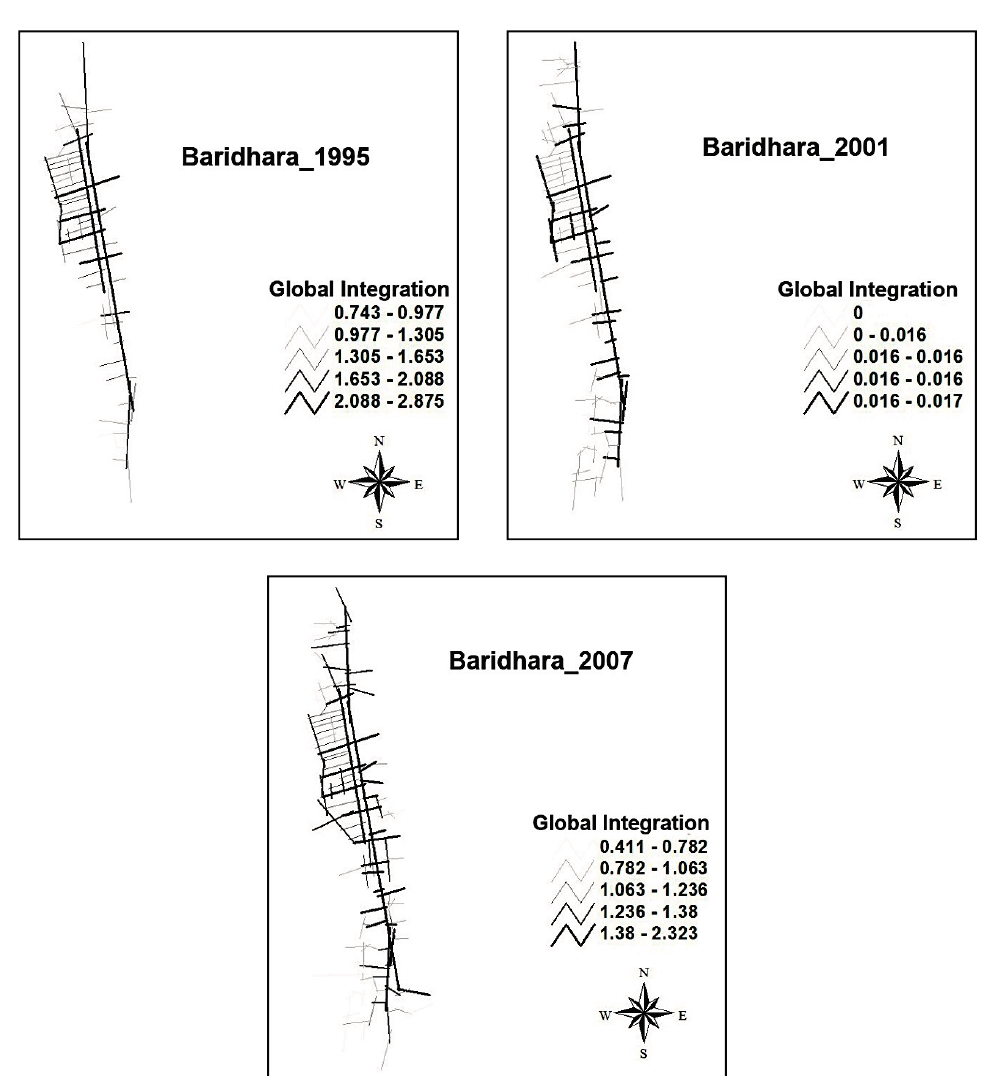
Figure 8. Global integration (R = n ) maps of ward 18 (Baridhara) in different time periods (not to